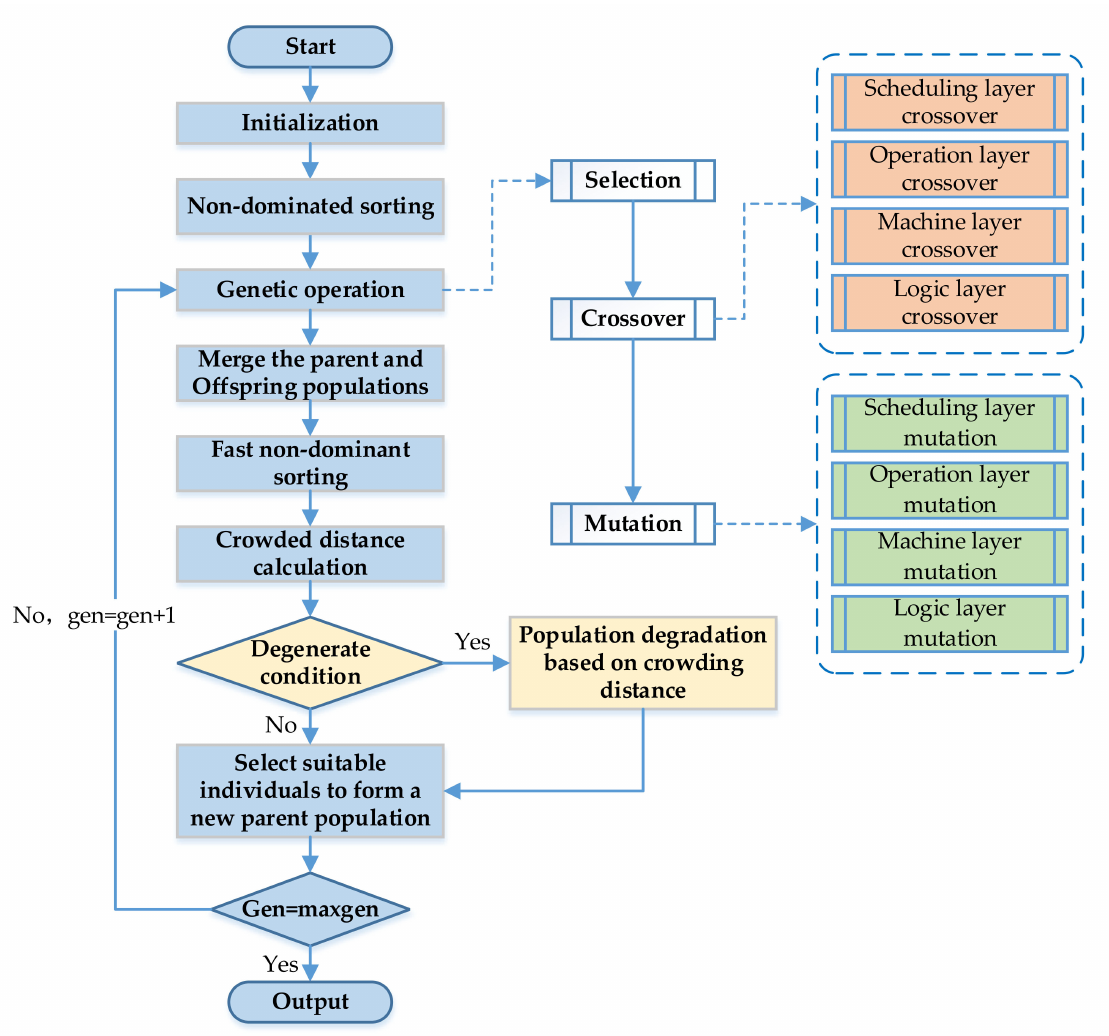
Figure 5. NSHMSGA